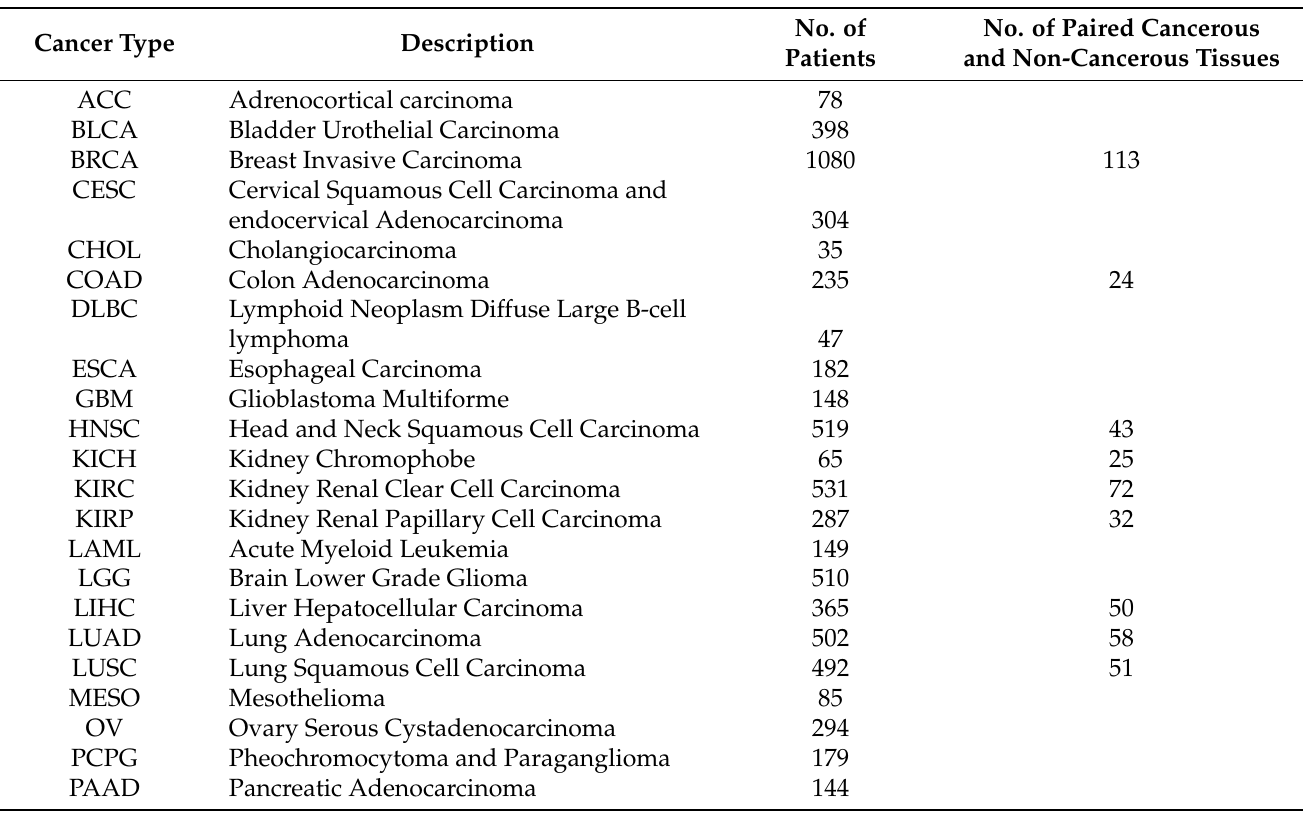
Table 1. A total of 9514 patients of 33 different types of TCGA cancers were analysed in this study. Cancer